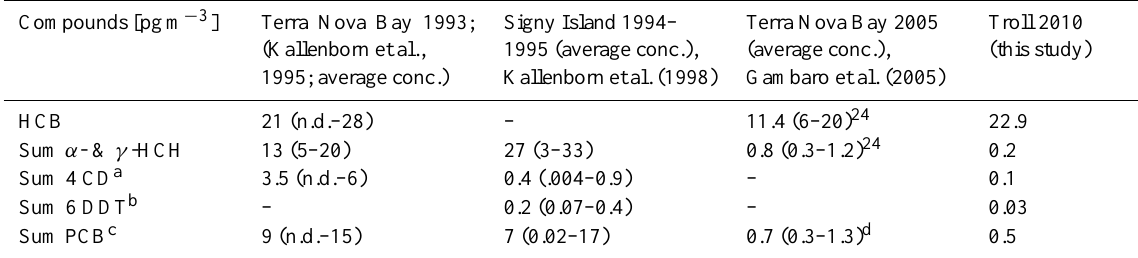
Table 2. Atmospheric POP distribution in Antarctic air; a comparison (concentration range in